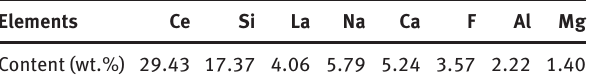
Table 1: The chemical composition of rare earth polishing powder waste